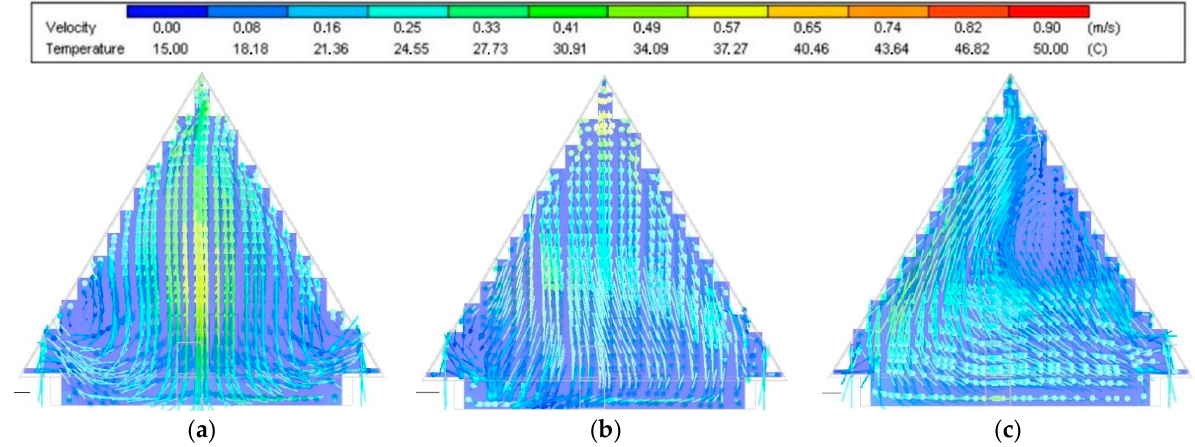
Figure 18. Simulated airflow paths on 6.6. at 2:00 a.m. in cross section: ( a ) 0.8 m from the sanctuary wall; ( b ) in the middle of attic space; ( c ) 0.8 m from the wall of the tower.